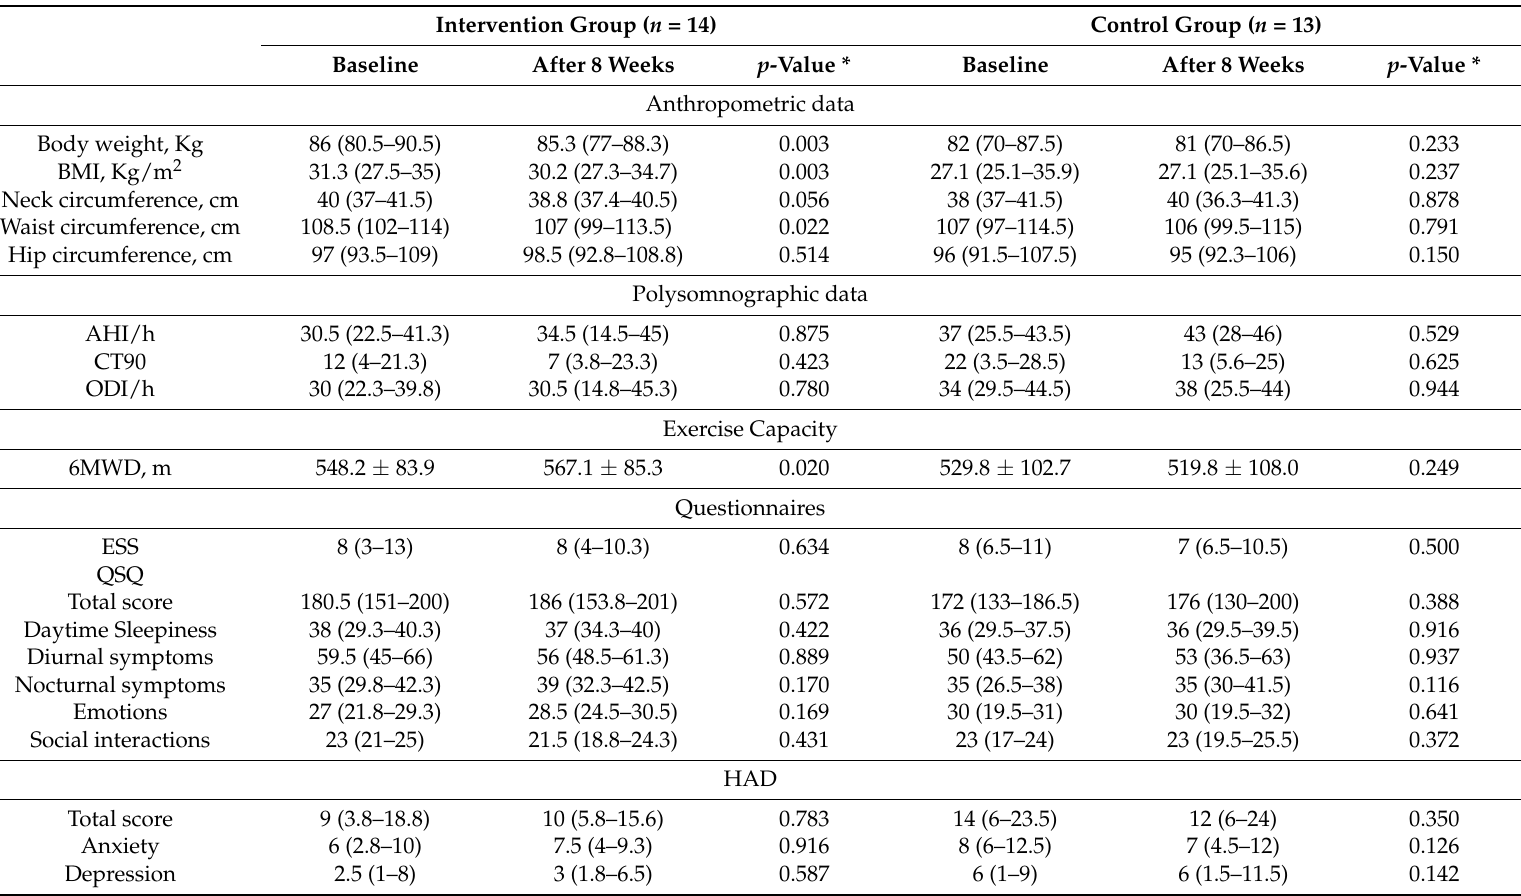
Table 2. Changes between variables according to intervention